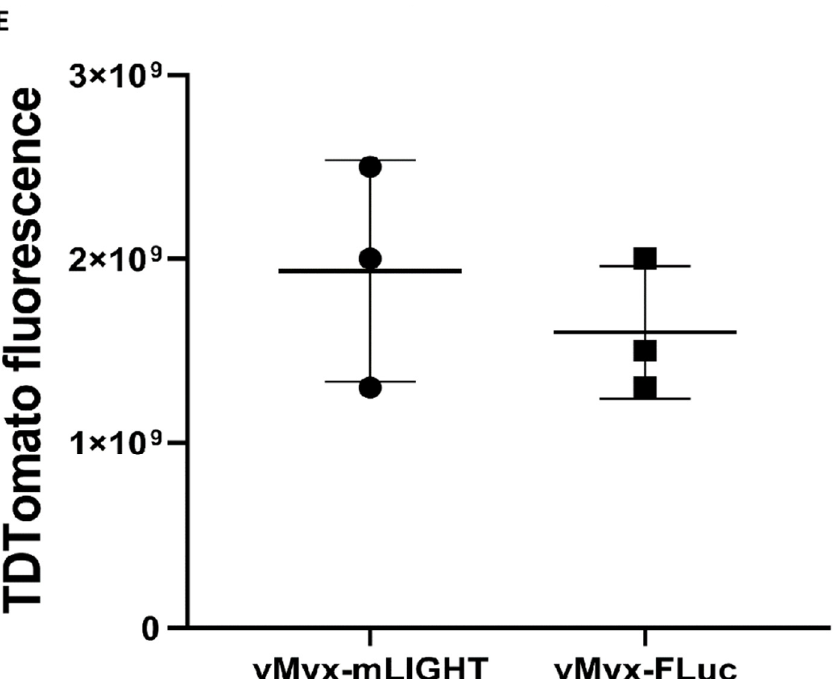
Figure 4. vMyx-mLIGHT systemically delivered via PBMC carrier cells produced increased tumor- specific tdTomato expression in K7M2 tumor beds indicative of increased levels of delivered virus. ( A ) fluorescent images showing tdTomato expression in ( i ) liver, spleens and tumor-bearing lungs from K7M2-luc pre-seeded animals treated with vMyx-mLIGHT + PBMCs and ( ii ) with systemic infusion of naked virus vMyx-mLIGHT. ( B ) A scatter plot showing tdTomato fluorescence images of lungs from animals treated with vMyx-Fluc, or vMyx-mLIGHT, with or without PBMCs and delivered into animals with or without K7M2-luc induced tumors. ( C ) A table showing number of tumors that exhibited tdTomato fluorescent signal from each condition, and average fluorescence value of each. ( D ) fluorescent images showing tdTomato signal in lungs excised from K7M2-luc-bearing mice and ex vivo infected with: ( i ) uninfected, ( ii ) free vMyx-mLIGHT, or ( iii ) free vMyx-Fluc. ( E ) scatter plot showing fluorescence values from panel D ii and iii. Error bars are mean ± SD.